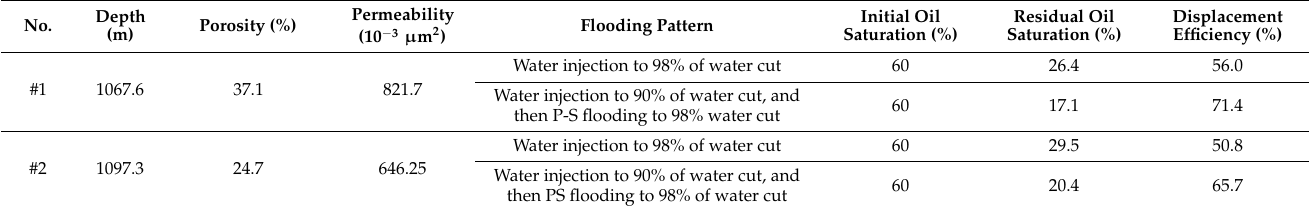
Table 1. Core flooding results for the two water-wet rock